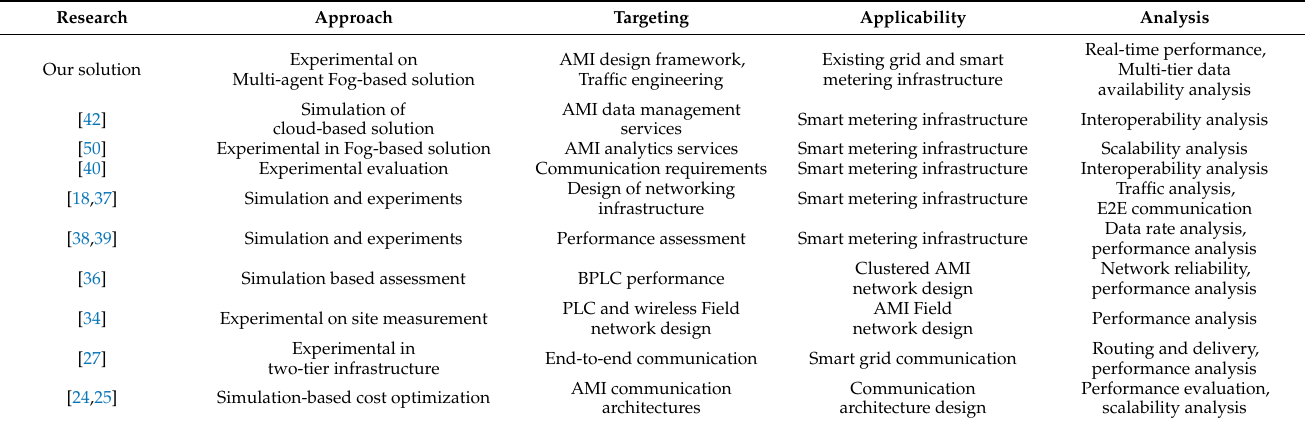
Table 1. Summarized review of recent studies regarding the design, analysis and AMI